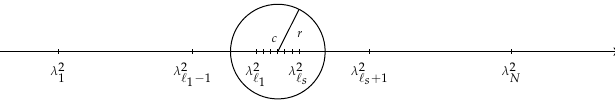
Figure 1. Schematic representation of the wanted